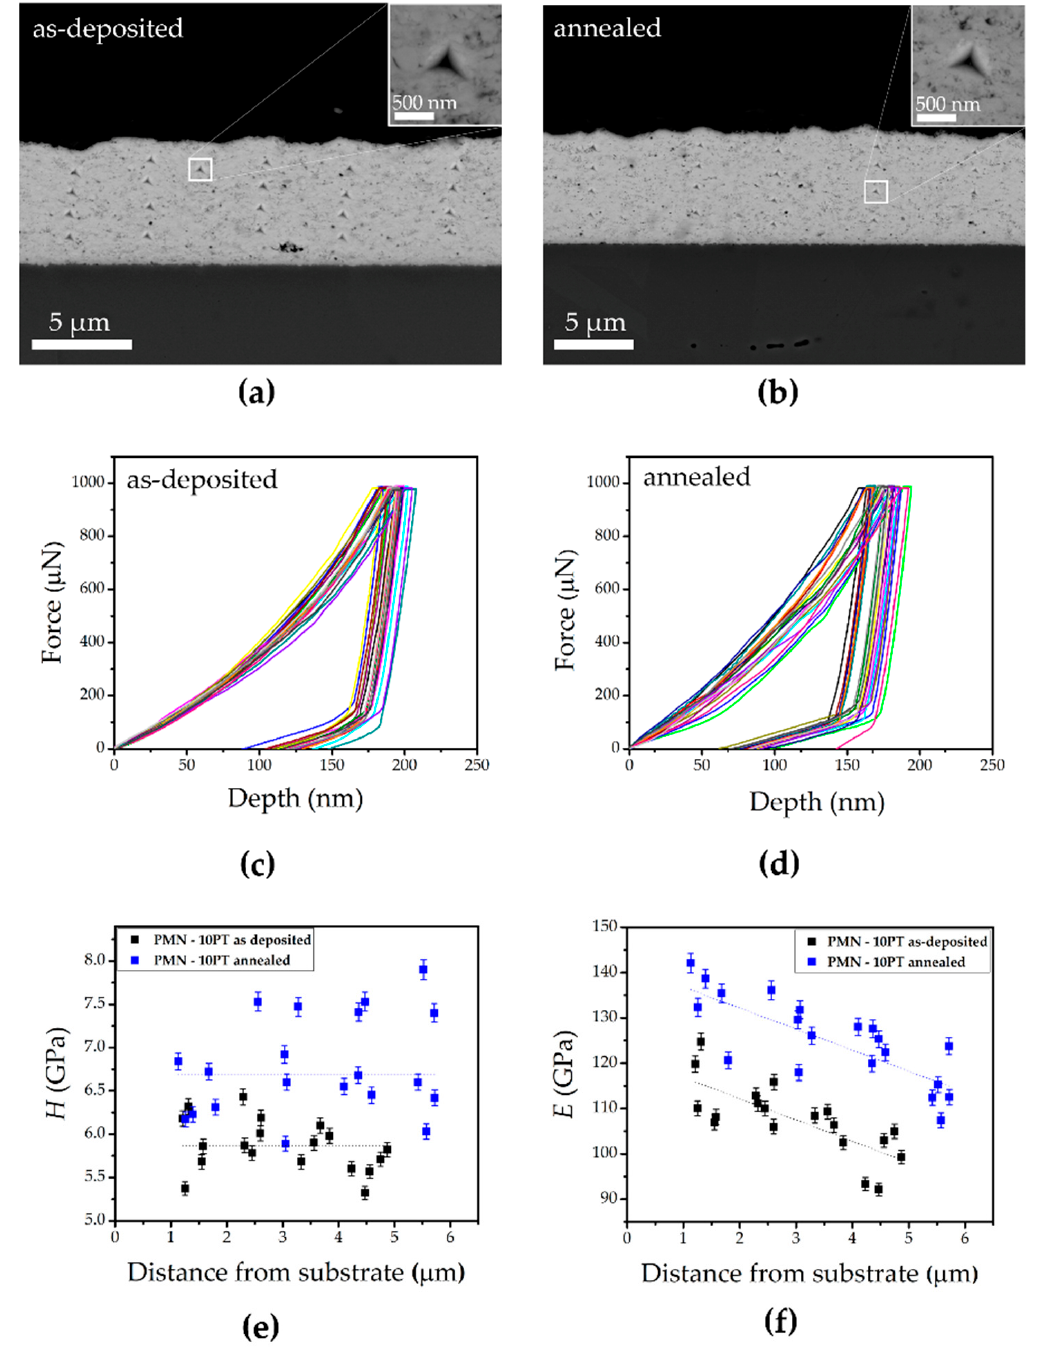
Figure 4. SEM images of indents made on cross-sections of ( a ) the as-deposited and ( b ) annealed film. Force-depth curves of ( c ) the as-deposited and ( d ) annealed film. ( e ) Hardness calculated from individual measurements plotted against indentation position for both films. ( f ) Young’s modulus calculated from individual measurements, plotted against the position of the indentation for both films. The error bars represent the uncertainty of the method as determined from measurements on the fused-silica standard. The dashed lines serve only as a guide to the eyes.